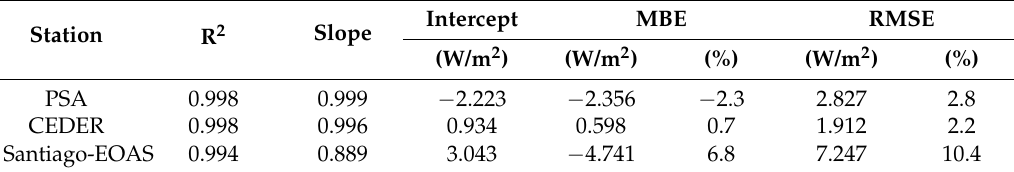
Table 4. Statistics of